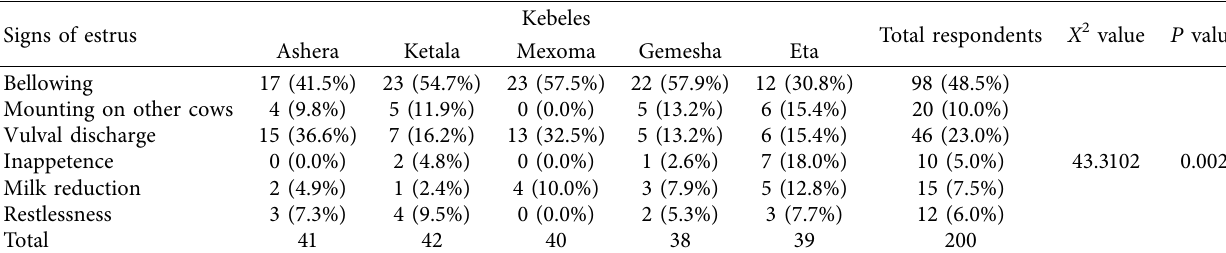
Table 7: Estrus signs respondents used to take their cows for AI